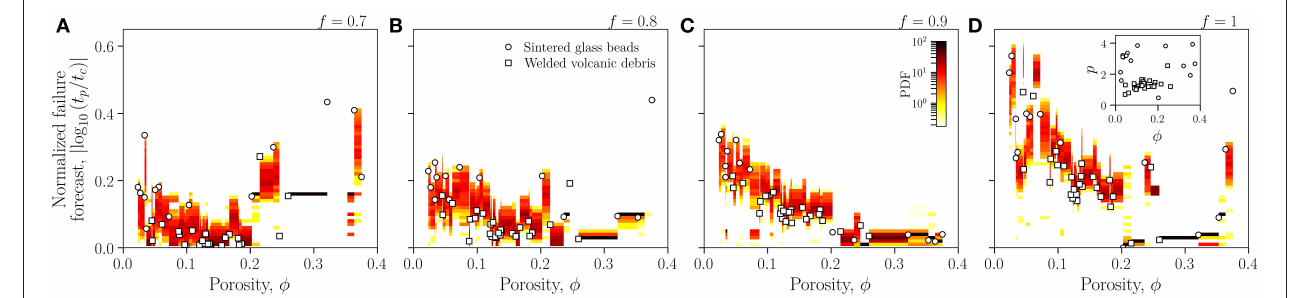
FIGURE 5 | A probability map for what the likely error on a forecast time would be as a function of porosity. We give this for different fractions of a complete sequence in panels (A–D) . A normalized failure forecast of unity (zero on this log axis), represents a perfect forecast. We show that there is a high probability of a perfect forecast at high porosities, but a low probability of good forecast at low porosities. See text for the details of the probability mapping. Inset to (D) shows the best-fit p exponent of the TROL obtained using (Equation 5) for f 1. =